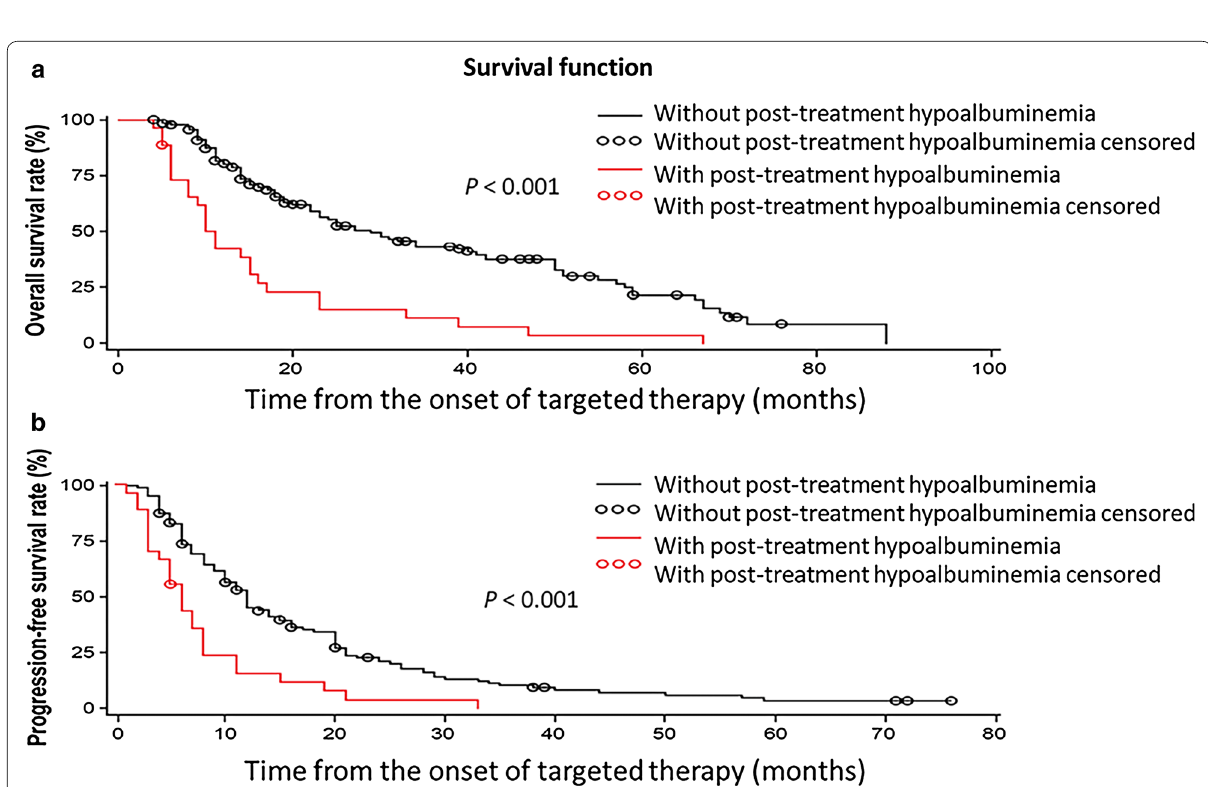
Fig. 2 Overall survival (OS) and progression-free survival (PFS) curves of patients with metastatic renal cell carcinoma with and without post-treat- ment hypoalbuminemia who received sorafenib or sunitinib as first-line therapy. In the post-treatment hypoalbuminemia group, OS ( a ) and PFS ( b ) rates are significantly lower than those in the normal post-treatment albumin level